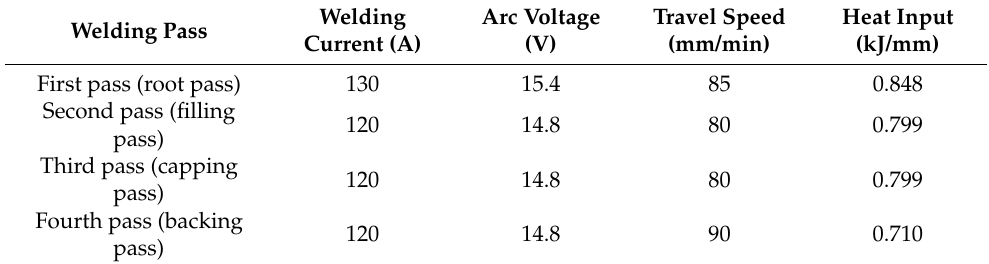
Table 2. Welding